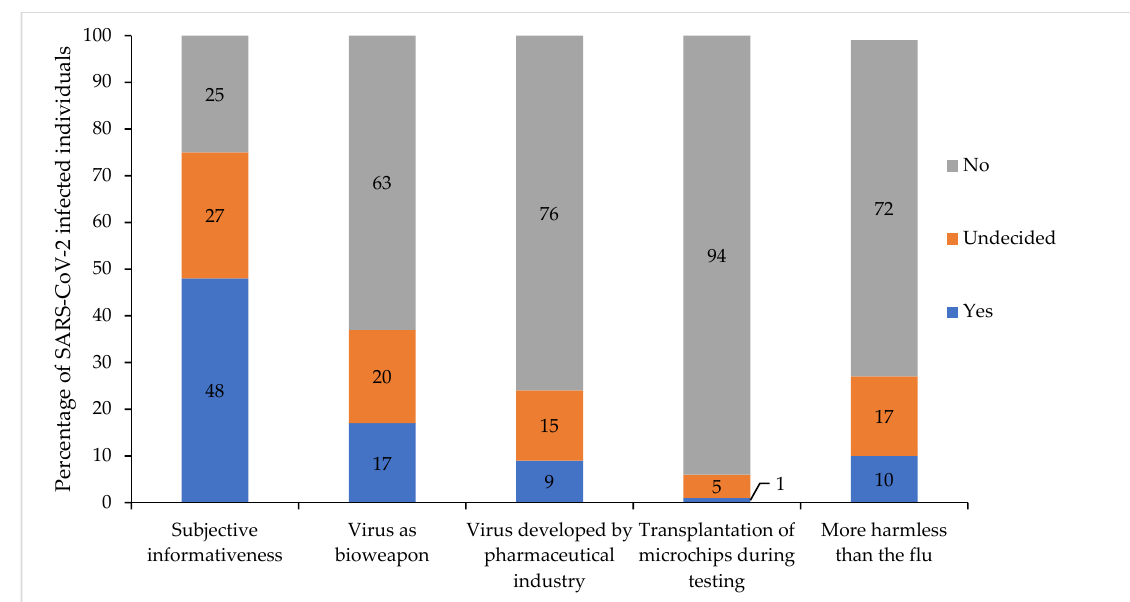
Figure 3. Subjective informativeness and susceptibility to conspiracy theories ( n = 224).